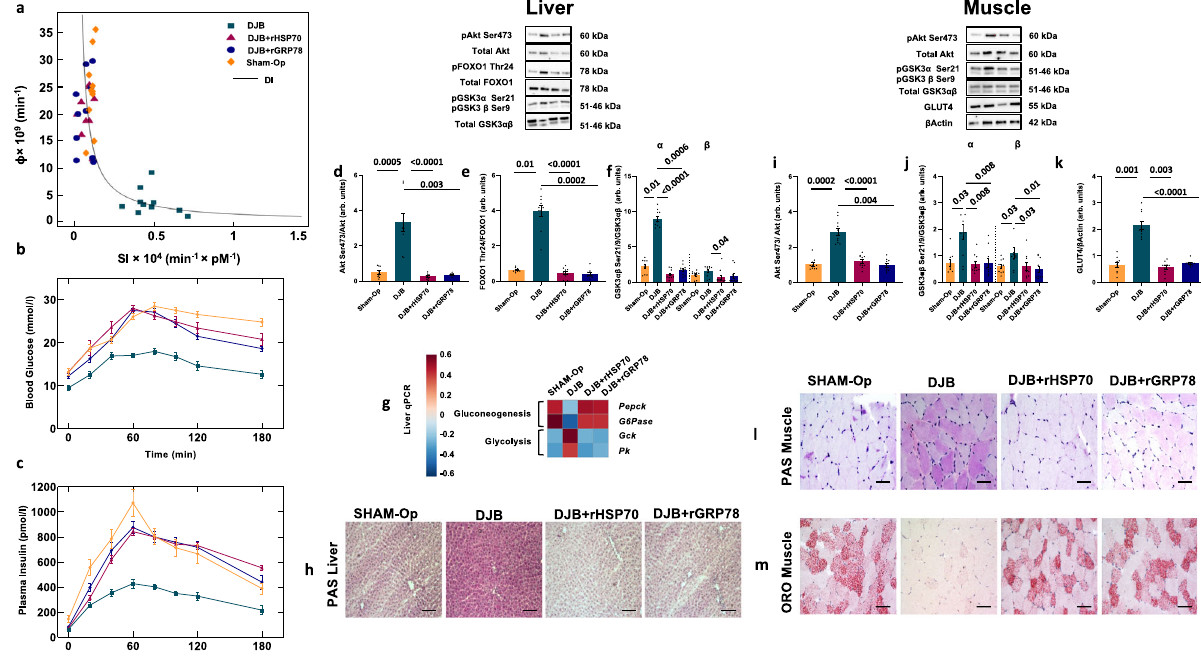
Fig.6|EffectsofHSP70orGRP78infusioninDuodenal-JejunalBypass(DJB)on insulinsensitivity.a Glucosedispositionindex(DI)metricsshowingexperimental data and fi tting curves. Total β -cell responsivity to glucose ( Φ ) is a function of whole-body insulin sensitivity (SI). b , c Time courses of blood glucose and plasma insulin concentrations during an oral glucose tolerance test. d – f Hepatic phos- phorylation of Akt on Ser473 ( d ), FoxO1 on Thr24 ( e ), and GSK3ab on Ser21/9 ( f ). g Gene expression of key enzymes involved in hepatic gluconeogenesis and gly- colysis. h RepresentativeimagesshowingperiodicacidSchiff(PAS)stainingofliver section from ratsfed HFD thatunderwent Sham-operation or DJB and infusedwith